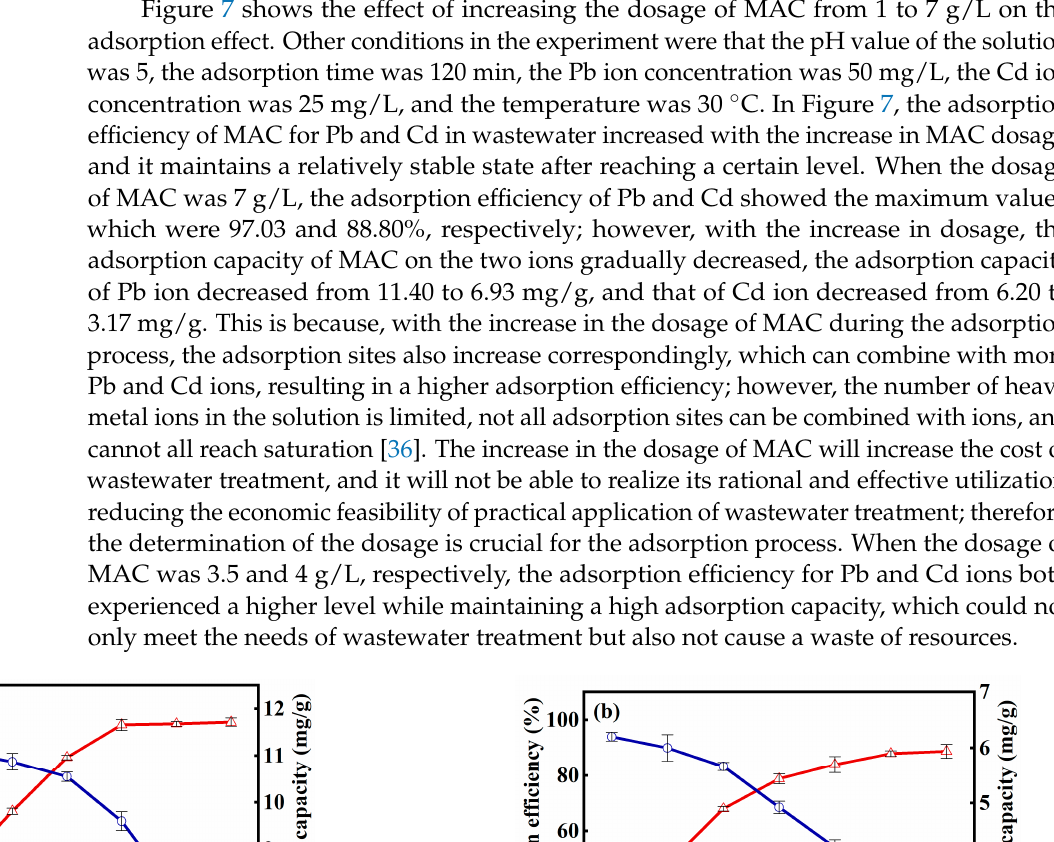
Figure 6. Influence of adsorption time on adsorption effect: ( a ) Pb ion; ( b ) Cd ion .